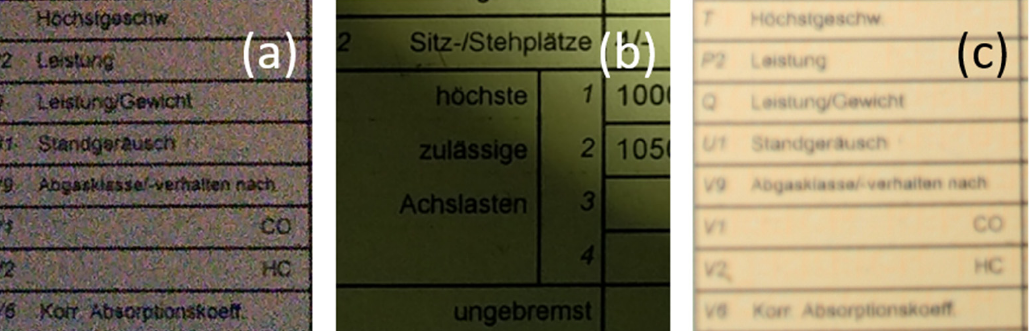
Figure 3. Main distortion problems encountered in document images: ( a ) A document photo, as usually taken from a smartphone with a low amount of light, causing the noise intensity to increase. ( b ) A document image with shadow; some parts are unreadable, whereas some parts are still easily readable with the naked eye; ( c ) A document image with blur; the text in this image is barely recognizable with the naked eye. Source: our own images.